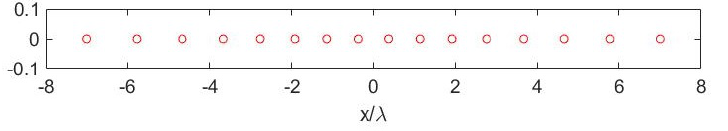
Figure 11. SVO points for the case a T = 5 λ , a R = 7 λ , d = 7 λ and N =